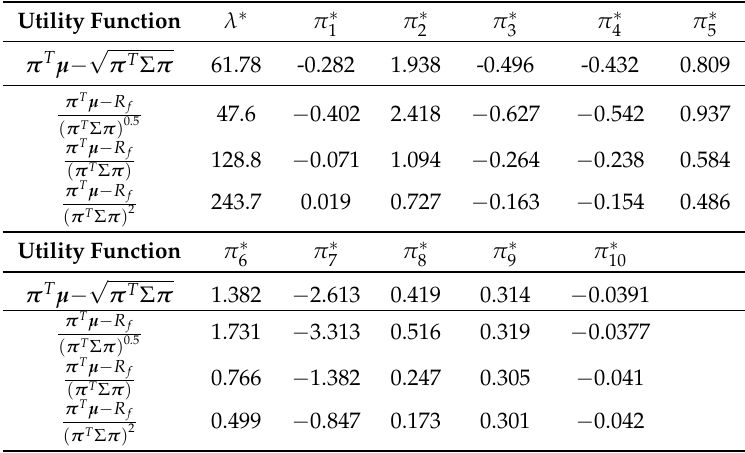
Table 3. The solutions π ∗ for different models: Mean standard deviation (MSD), Sharpe ratio (SR) and generalized